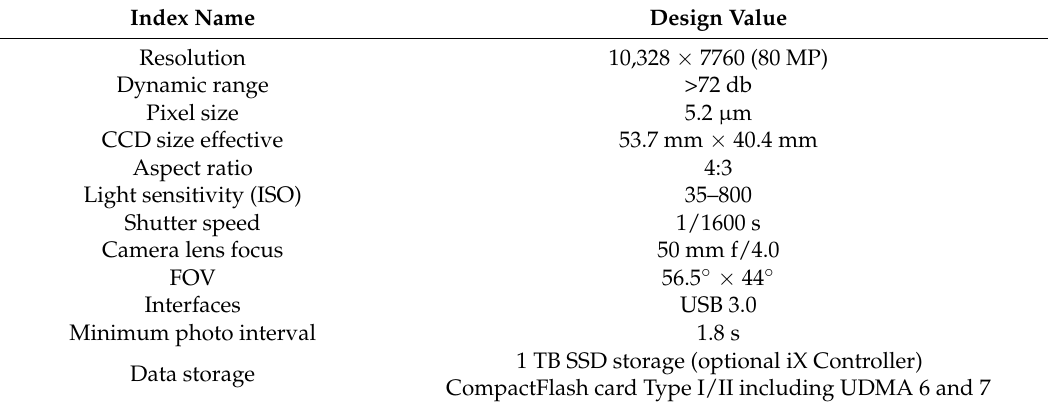
Table 1. iXU-R180 technical